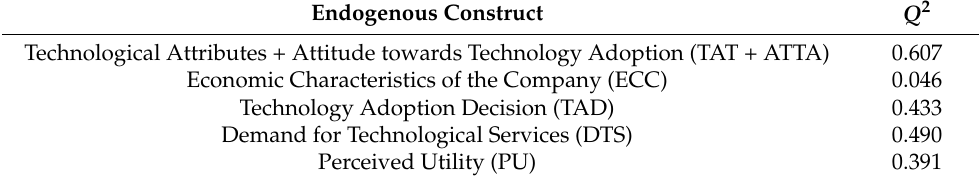
Figure 8. Proposed final model. Table 14. Predictive relevance ( Q 2 values). Table 13. Decomposition of the explained variance of the endogenous latent variable DTS.